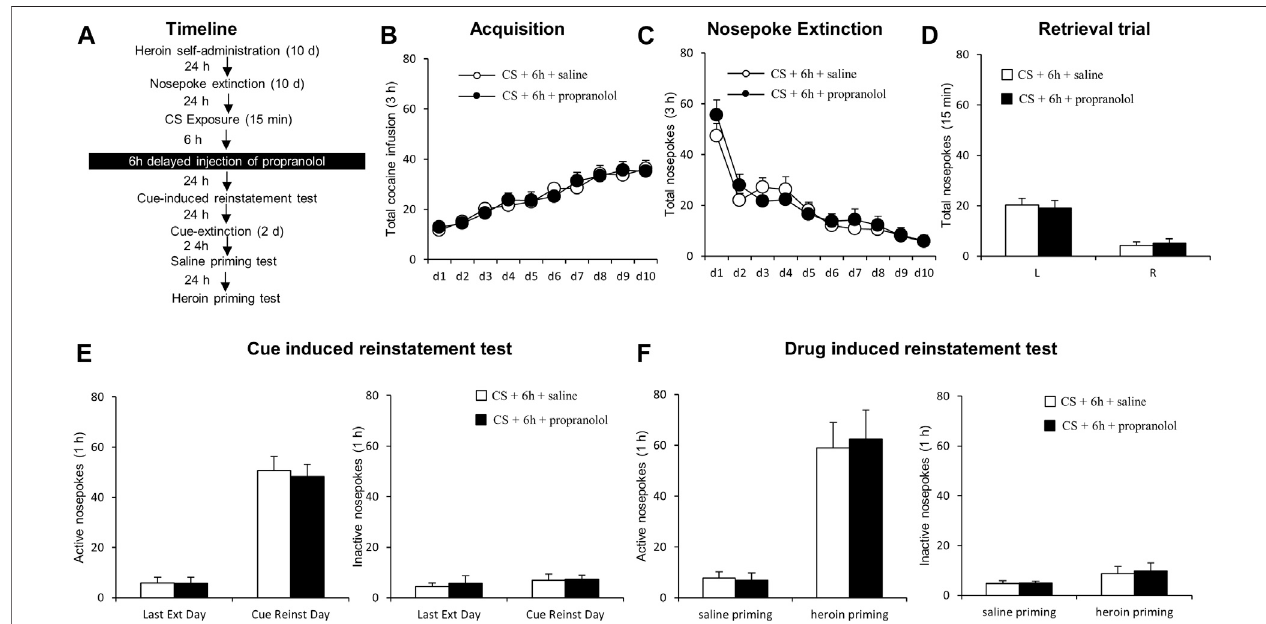
FIGURE 4 | Propranolol treatment 6 h following reactivation has no effect on subsequent reinstatement of heroin-seeking. (A) Schematic representation of the experimental procedure. (B) Total number ofinfusions across heroin self-administration sessions. (C) Nose-poke responses during the reactivation trial. (D) Nose-poke responses during the conditioned reinforcement test. (E) Active (left) and inactive (right) nosepoke responses during the last extinction session and the cue-induced reinstatement test. (F) Active (left) and inactive (right) nosepokes during the saline-or heroin-primed reinstatement test.